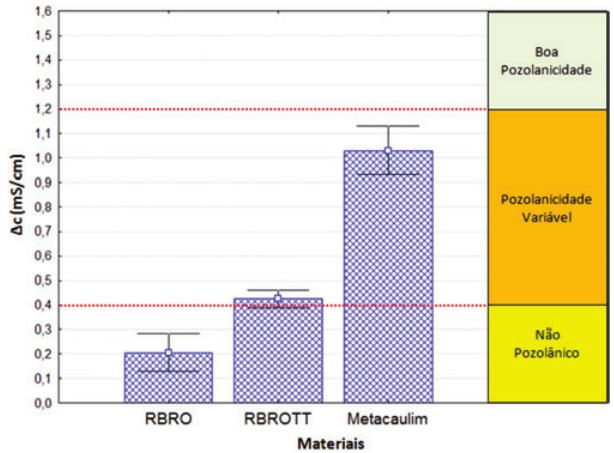
Ensaio de atividade pozolânica em argamassa de